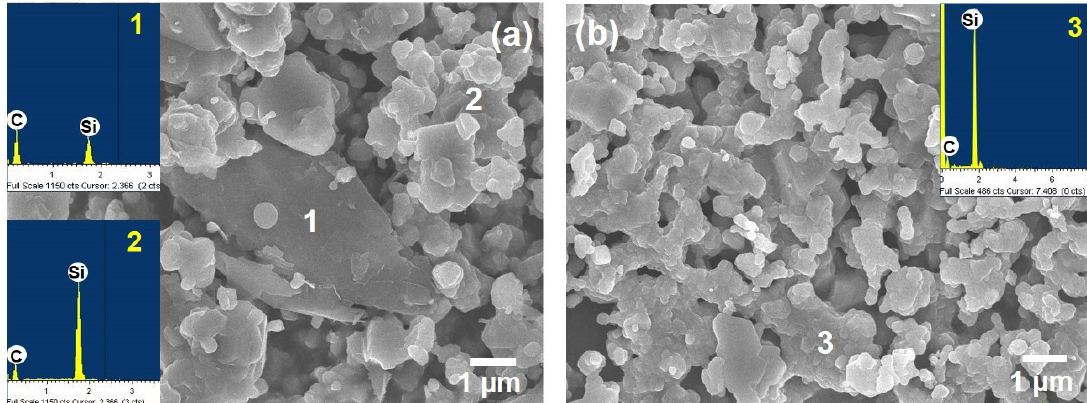
Figure 12. Microstructure of SiC powder ( a ) before and ( b ) after the carbon removal treatment; inset of